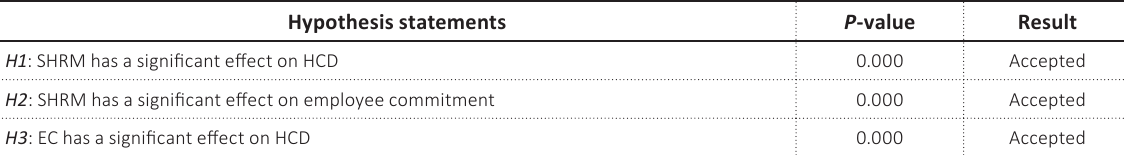
Table 8. Hypothesis testing of direct